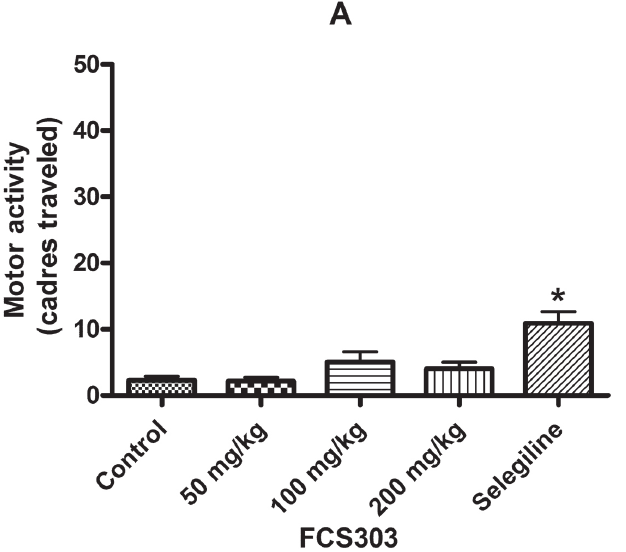
FIGURE 3B - Effect of administration of FCS303 (50, 100, and 200 mg/kg), control (vehicle 0.1 mL/10 g body weight), or selegiline (10 mg/kg) on motor activity in mice treated with reserpine (3 mg/kg). The animals were observed in the open- field test 24 h after administration of reserpine. n = 7–9. *p < 0.05 compared to the control